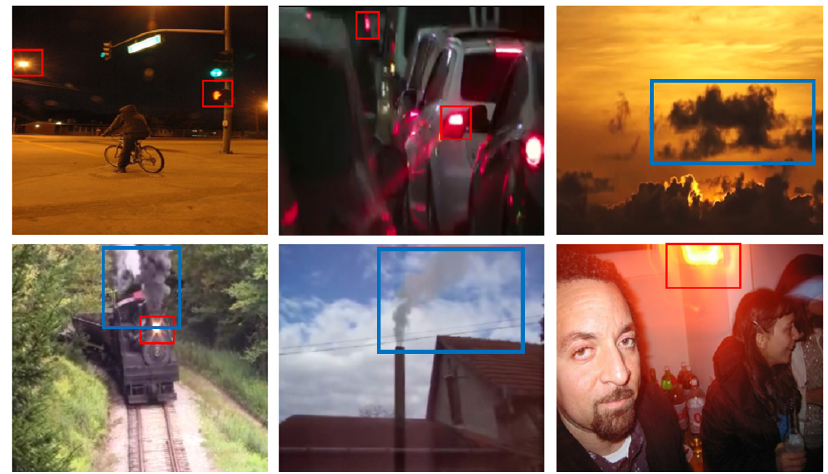
Figure 8. False positive results of Faster R-CNN fire detection. The red color box is flame prediction blue color box is smoke prediction [26].